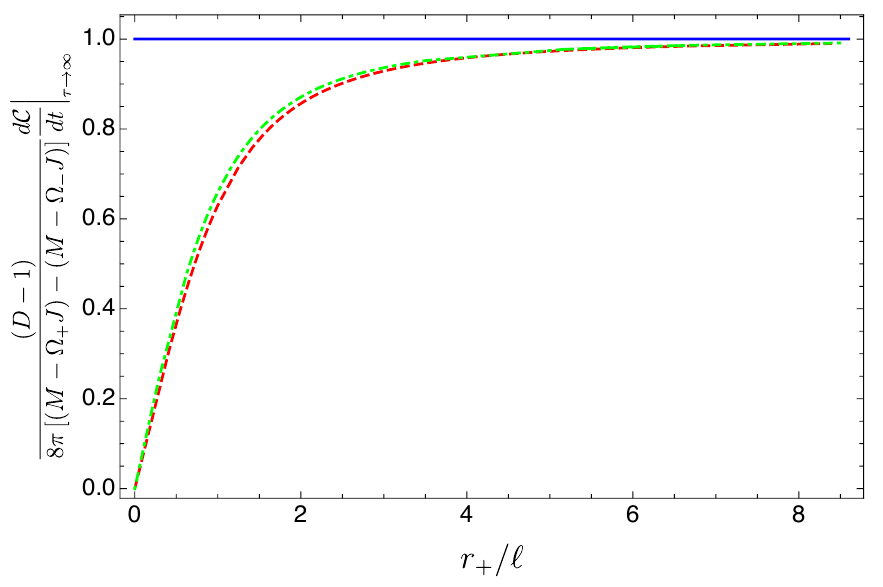
Figure 13. The late-time rate of complexity growth d C V /dτ is shown as a function of r + /‘ for spacetime dimensions D = 3 , 5 , 7 (solid blue, dashed red, and dot-dashed green, respectively). It is shown that the limit (5.23) is always approached from below. The fact that the late-time d C V /dτ can be expressed in this way in terms of the thermodynamic quantities of the black hole only in the large r + /‘ limit shows one of its shortcomings compared to d C A /dτ , which can expressed at late-times in terms of thermodynamic quantities of the black hole for all r + /‘